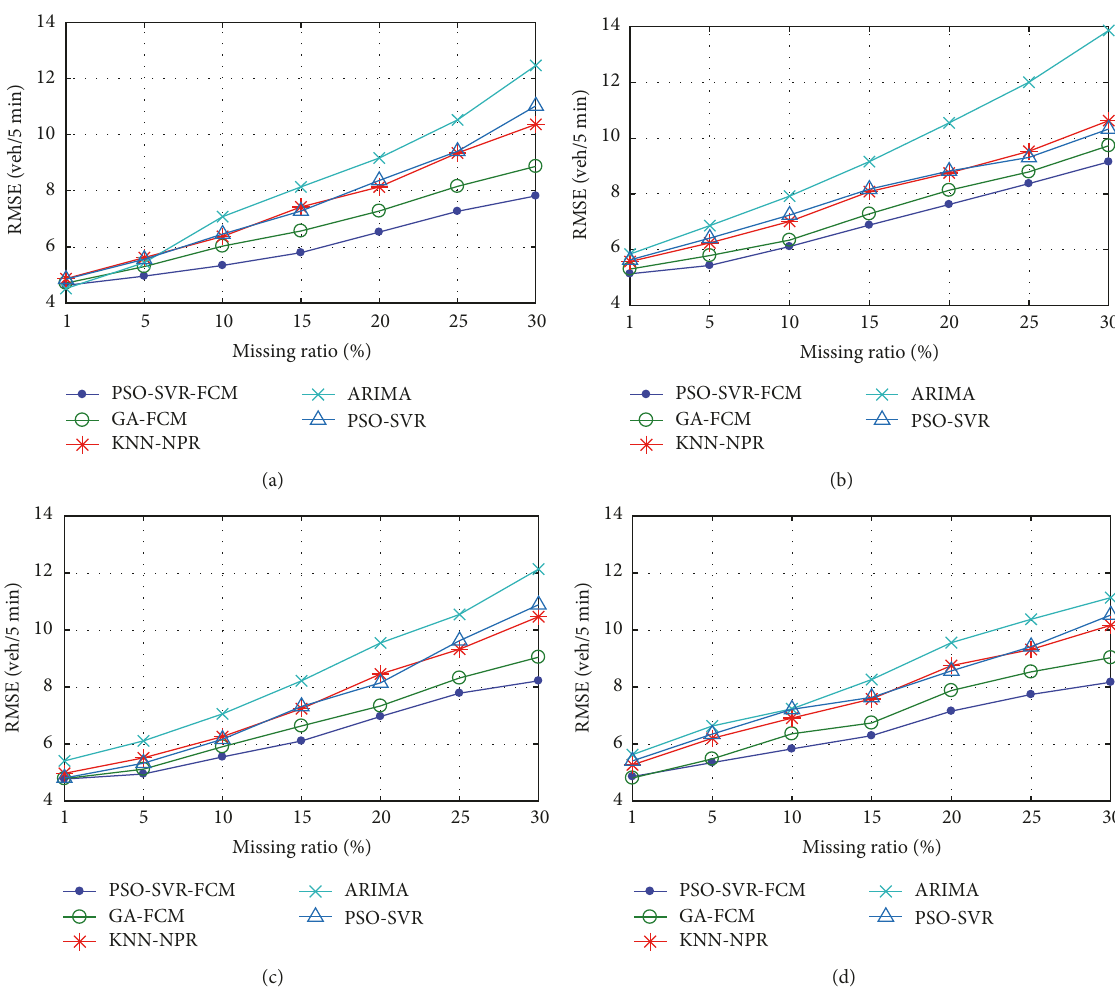
Figure 14: The RMSE curve of each method for comparison in MR pattern, using the traffic data collected from the detectors (a) NBXX13 (2) , (b) NBXX11 (4) , (c) DC00004964(E2), and (d)